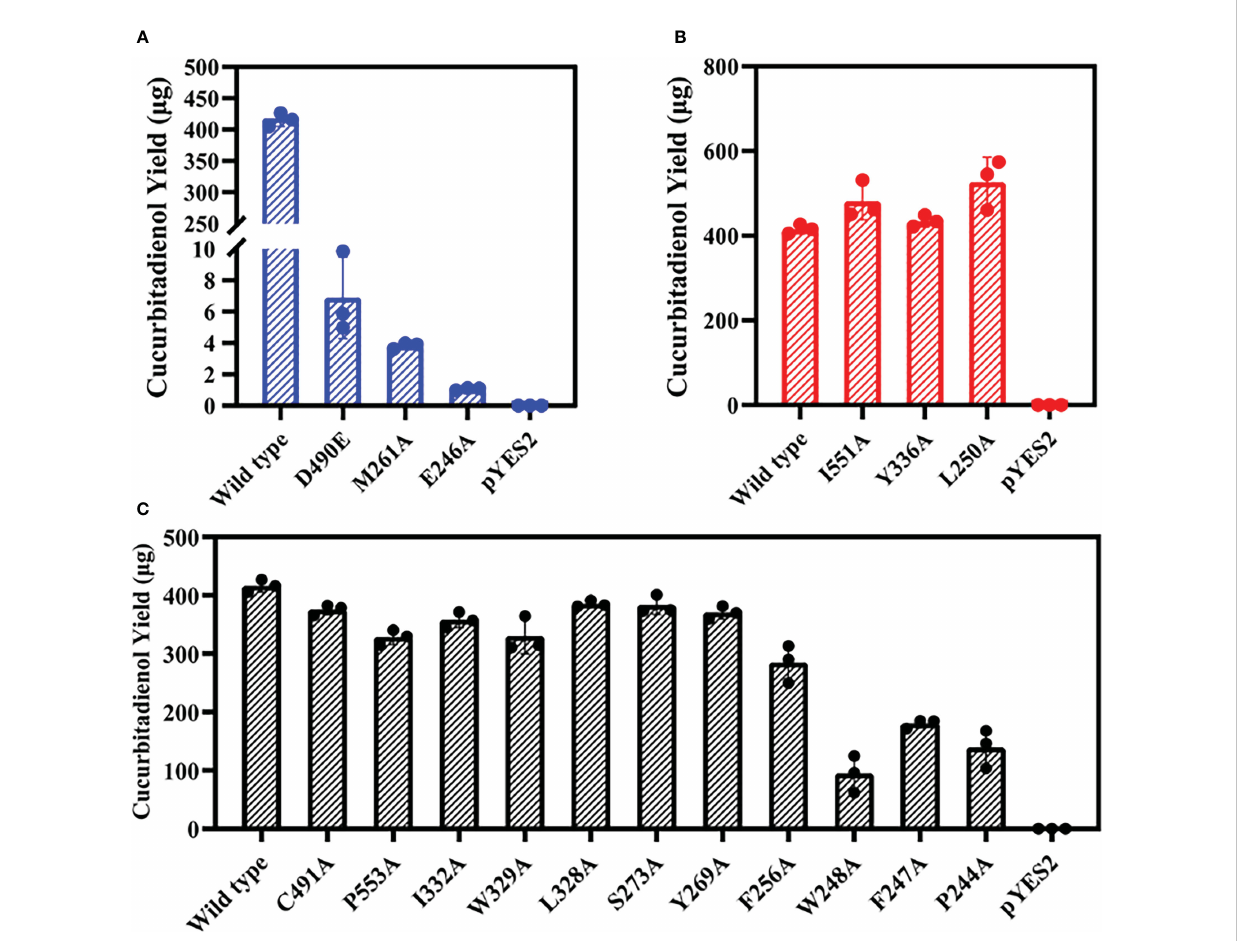
FIGURE 5 Total activities for the mutants obtained were evaluated against that of the wild-type HcOSC6 (100%). Data represent mean ± SD of three biological replicates. (A) Cucurbitadienol yield for the mutants D490E, M261A and E246A. (B) Cucurbitadienol yield for the mutants I551A, Y336A and